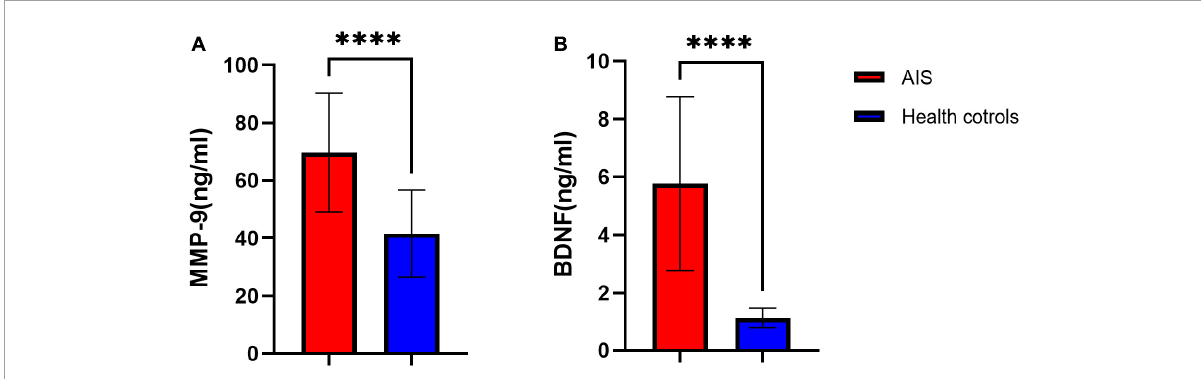
FIGURE2 Comparison of baseline serum MMP-9 (A) and BDNF (B) levels between the AIS group and the healthy control group at baseline. A 42 patients in the AIS group and 40 participants in the health control group were used for the analysis. AIS, acute ischemic stroke; data represent as mean ± SD, **** P < 0.001.